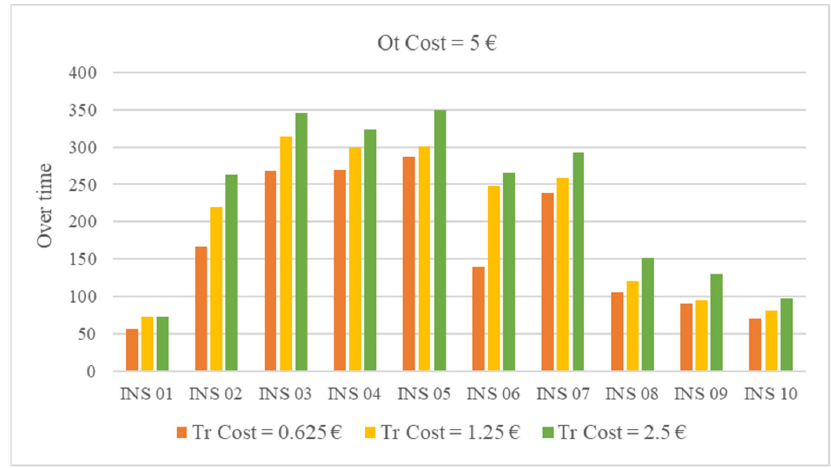
Figure 10. The amount of imposed “Overtime” with respect to various tardiness penalties.